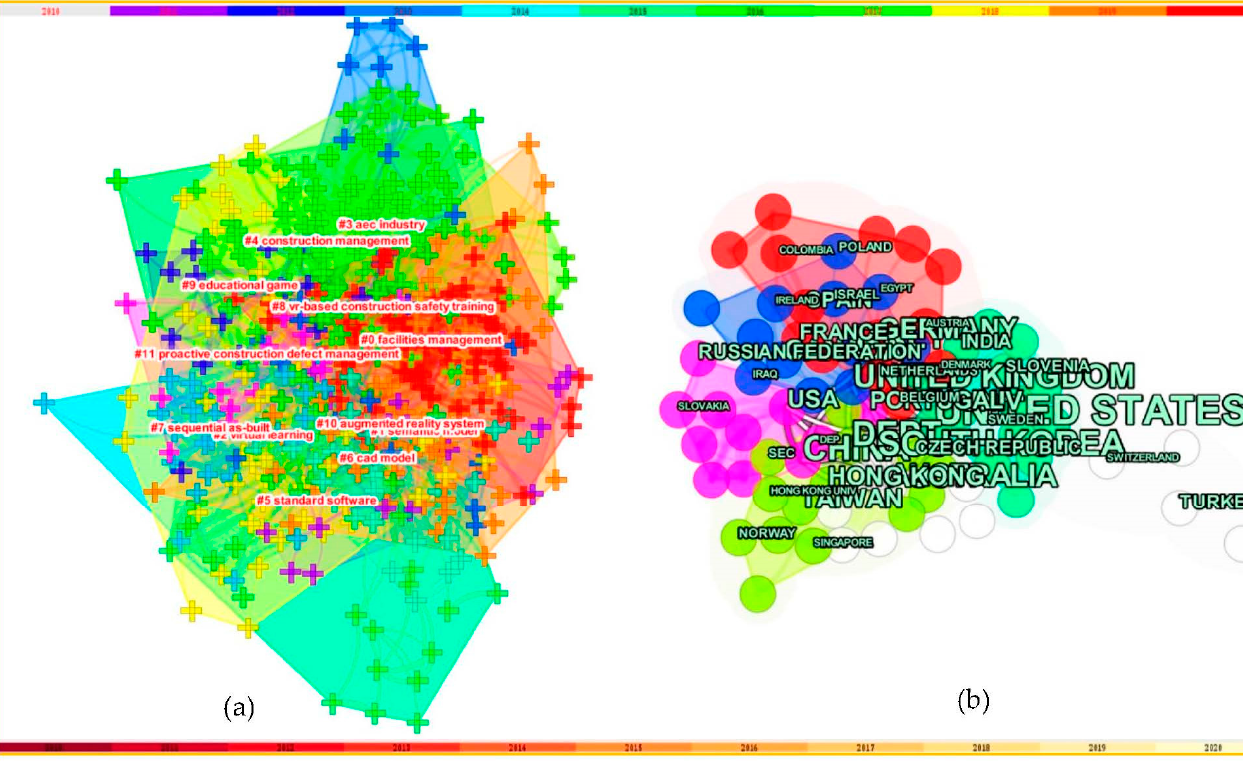
Figure 5. Conceptualised themes and contributions in the VR literature. ( a ) Visualising the 12 fragmented themes identified; ( b ) the contribution of different countries in developing VR applications.